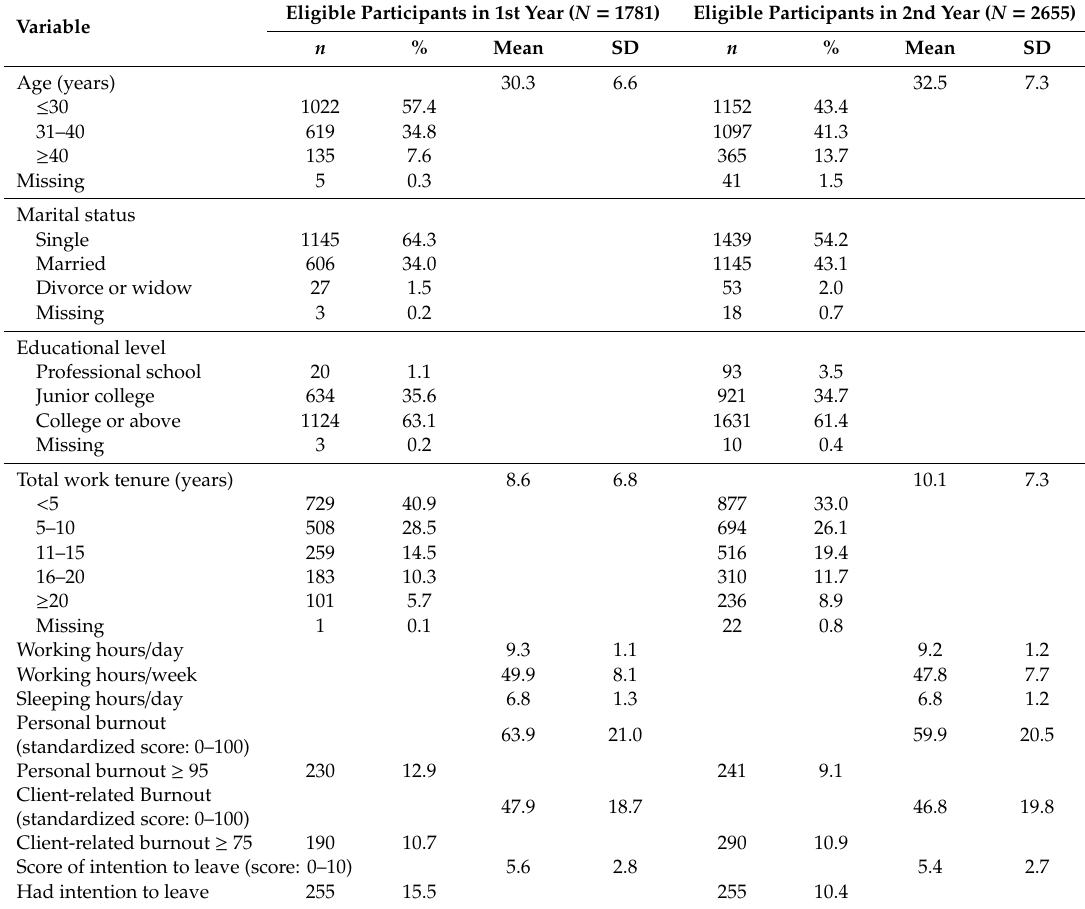
Table 1. Participant